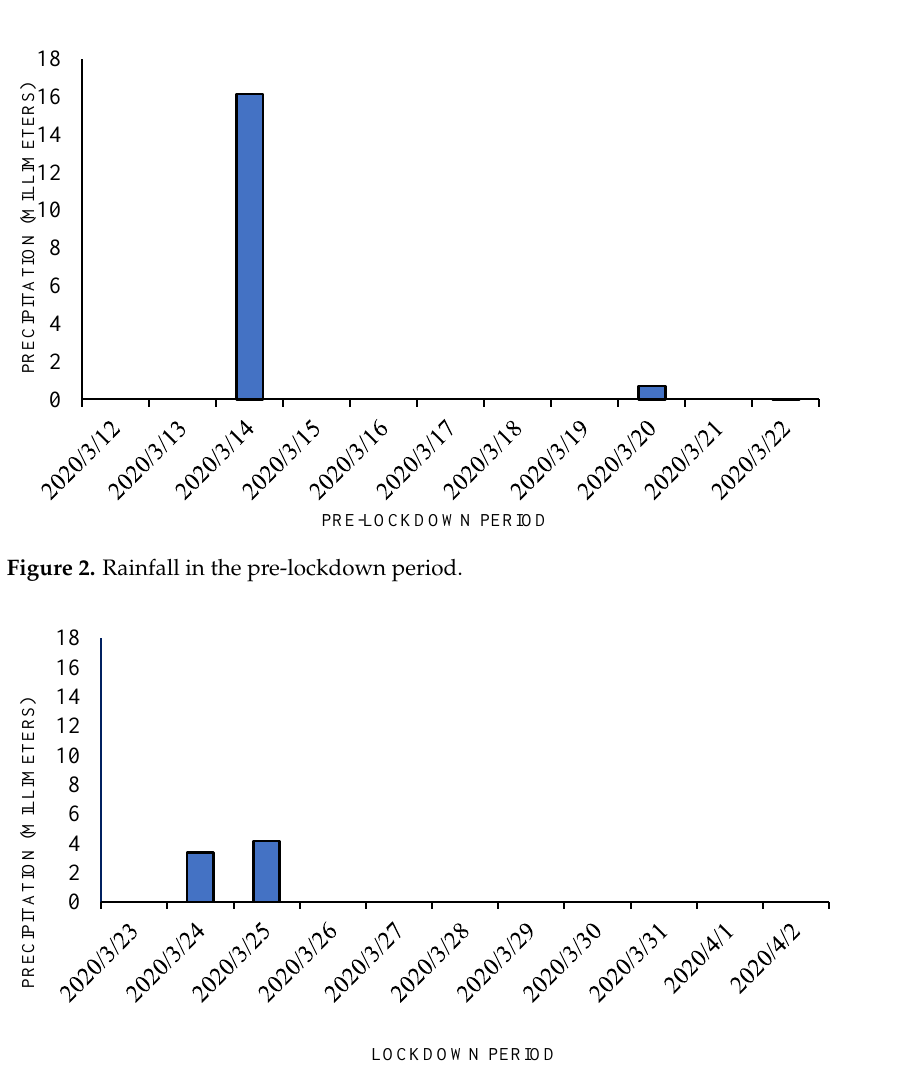
Figure 3. Rainfall during the lockdown period.